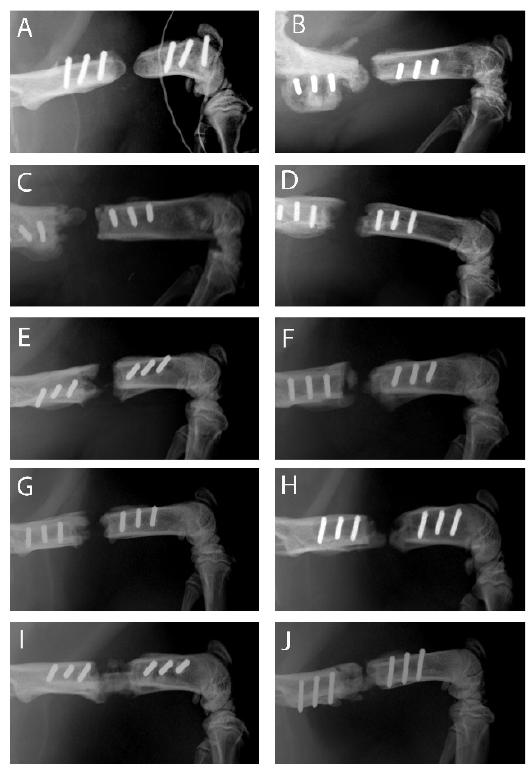
Figure 2. X-ray images of the different groups 4 weeks after surgery. Group 1—no implant— A + B ; 2—PLA cylinder alone— C + D ; 3—PLA cylinder + collagen type I— E + F ; 4—PLA cylinder + collagen type I + SDF-1— G + H ; 5—PLA cylinder + collagen type I + BMP-7— I + J .